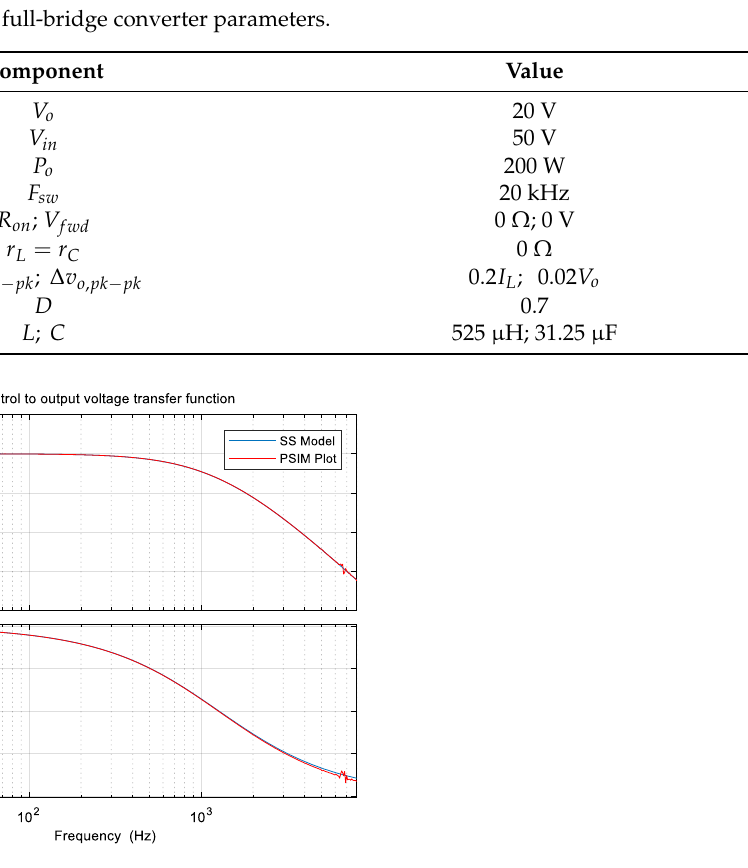
Figure 20. Control − to − output voltage transfer function for a Voltage − fed full bridge converter.